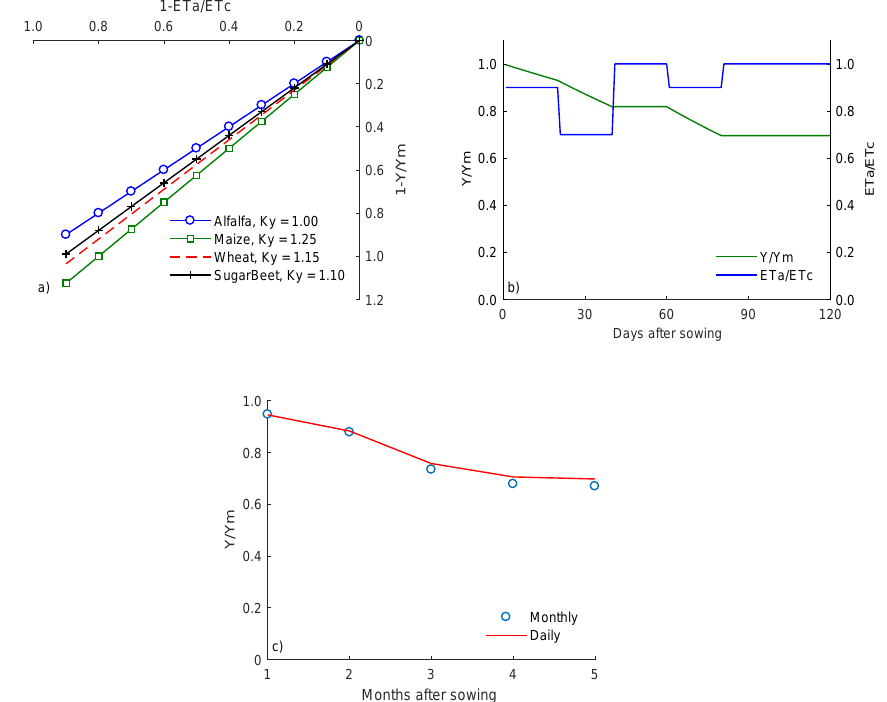
Figure 1. Representation of crop yield reduction, where ( a ) is the seasonal crop yield reduction function proposed by Doorenbos and Kassam [25] where Ky is the slope; ( b ) is the daily crop yield reduction for maize proposed by Raes et al. [31] where relative yield stays constant when the water demand is satisfied and decreases when it is not; and ( c ) represents daily and monthly approaches for